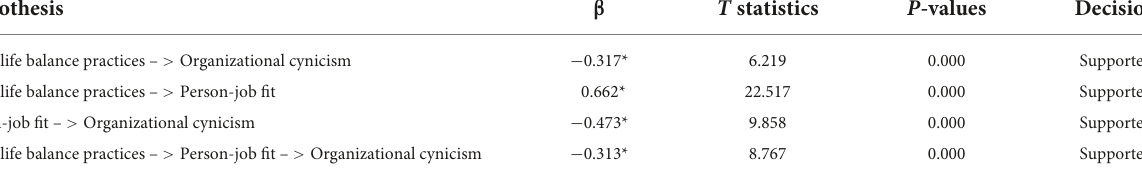
TABLE 6 Structural model